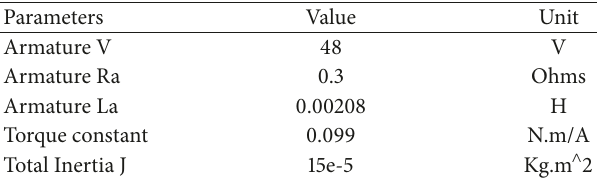
Table 6: PMDC motor parameters.